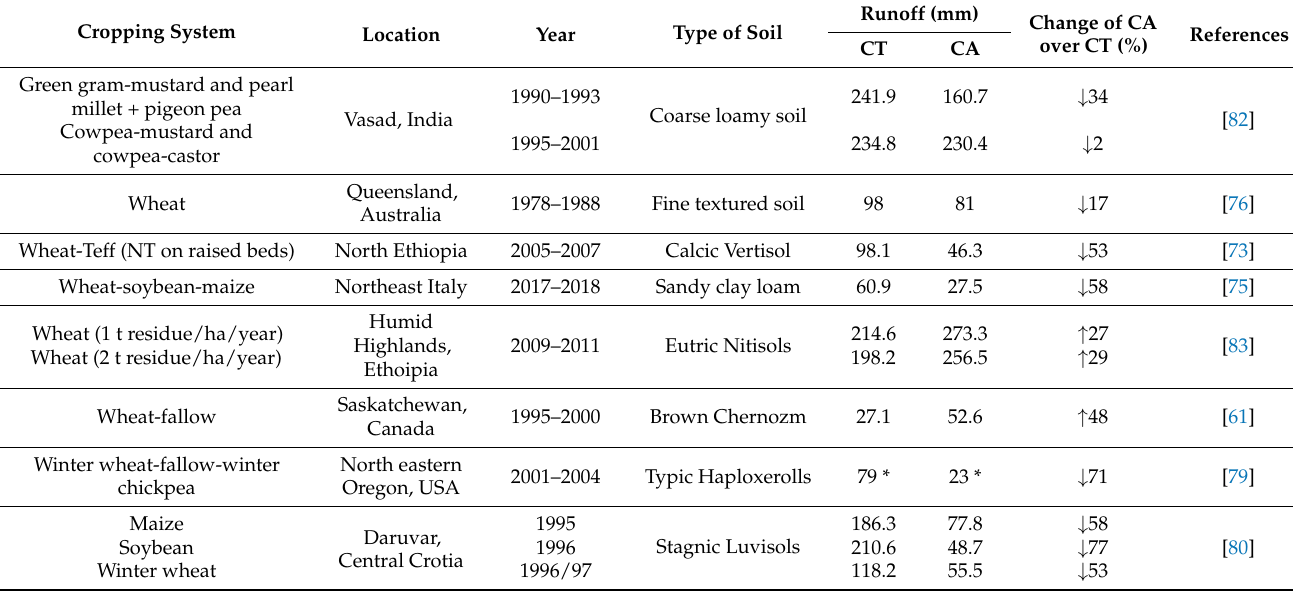
Table 3. Comparison of conservation agriculture (CA) and conventional tillage (CT) on surface runoff (mm). Cropping